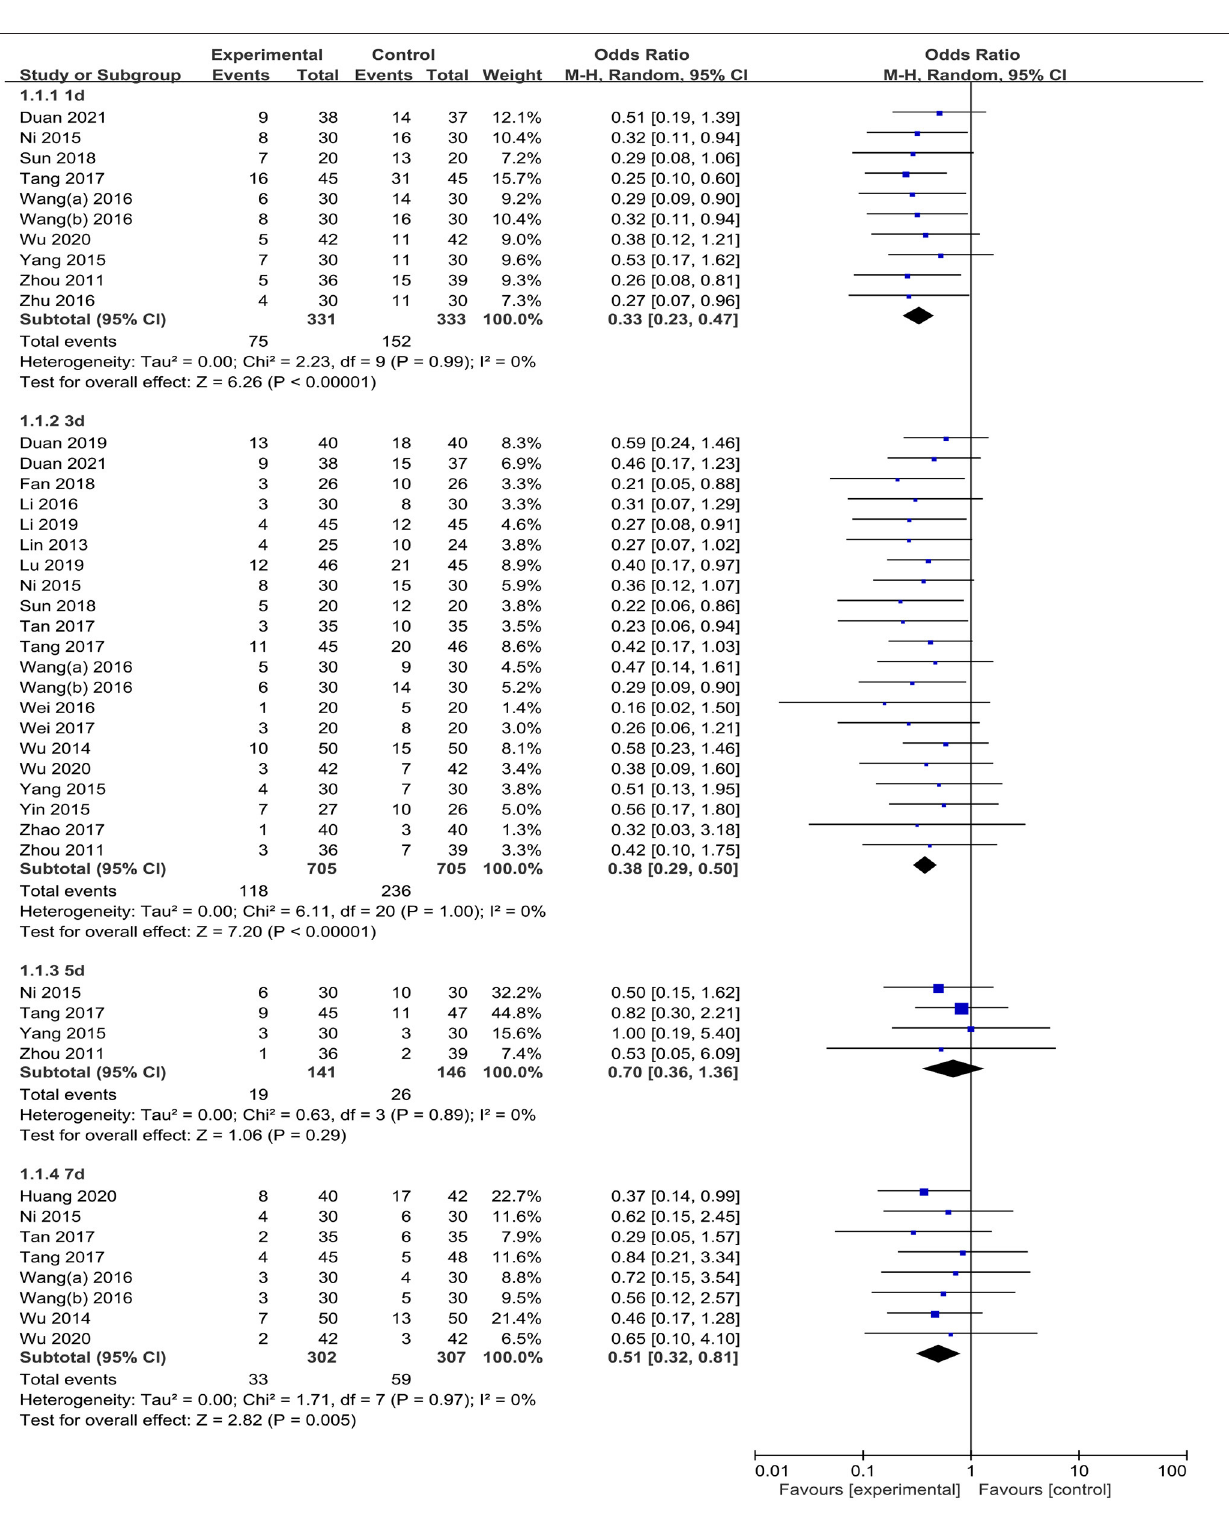
Frontiers in Medicine |